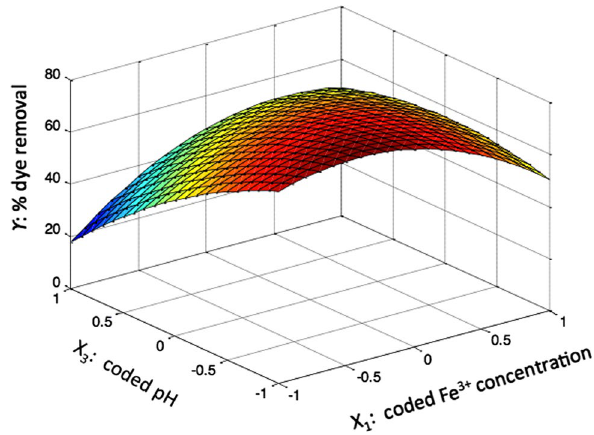
Fig. 3 Surface graph of dye removal showing interaction of Fe 3+ dos- age and H 2 O 2